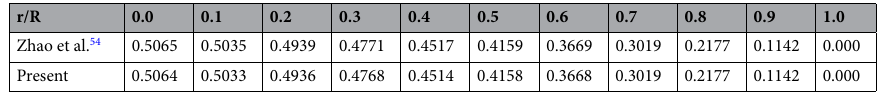
Table 2. Comparison of numerical results for the temperature